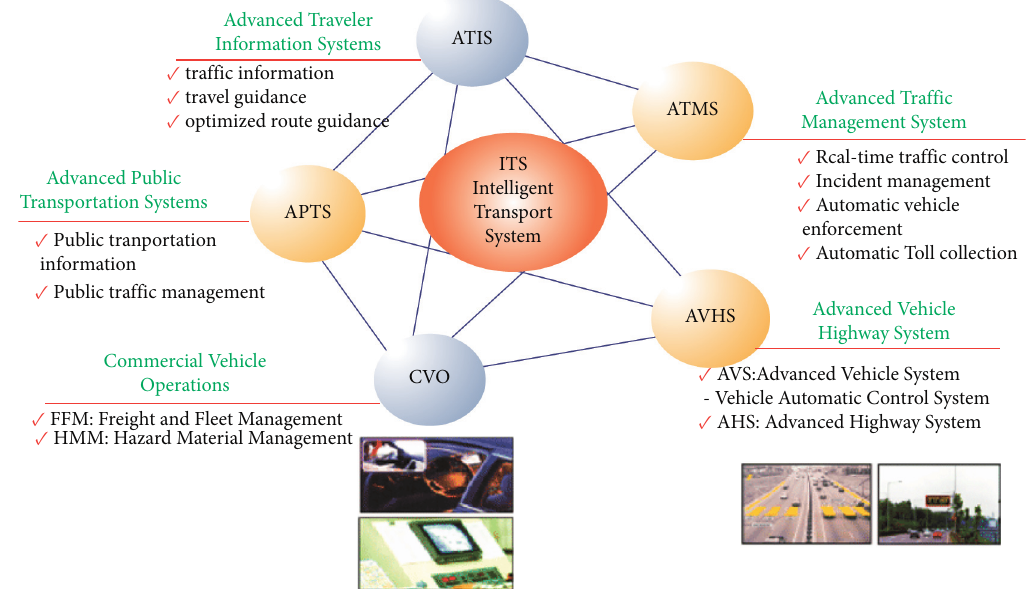
Figure 1: High-level architecture diagram for ITS